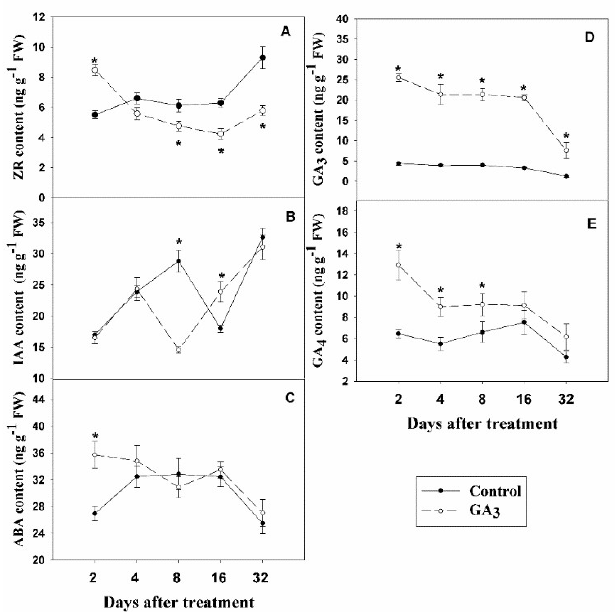
Figure 2. Effect of injecting plants with GA 3 on the level of zeatin riboside (ZR) ( A ), indole-3-acetic acid (IAA) ( B ), abscisic acid (ABA) ( C ), GA 3 ( D ) and GA 4 ( E ) in 1 cm-thick stems of garlic. Values are the means ± SD ( n = 4) and Student’s t-test was used to determine significant differences at the same period between the control group and GA 3 treatment group. Significance levels: * p < 0.05.